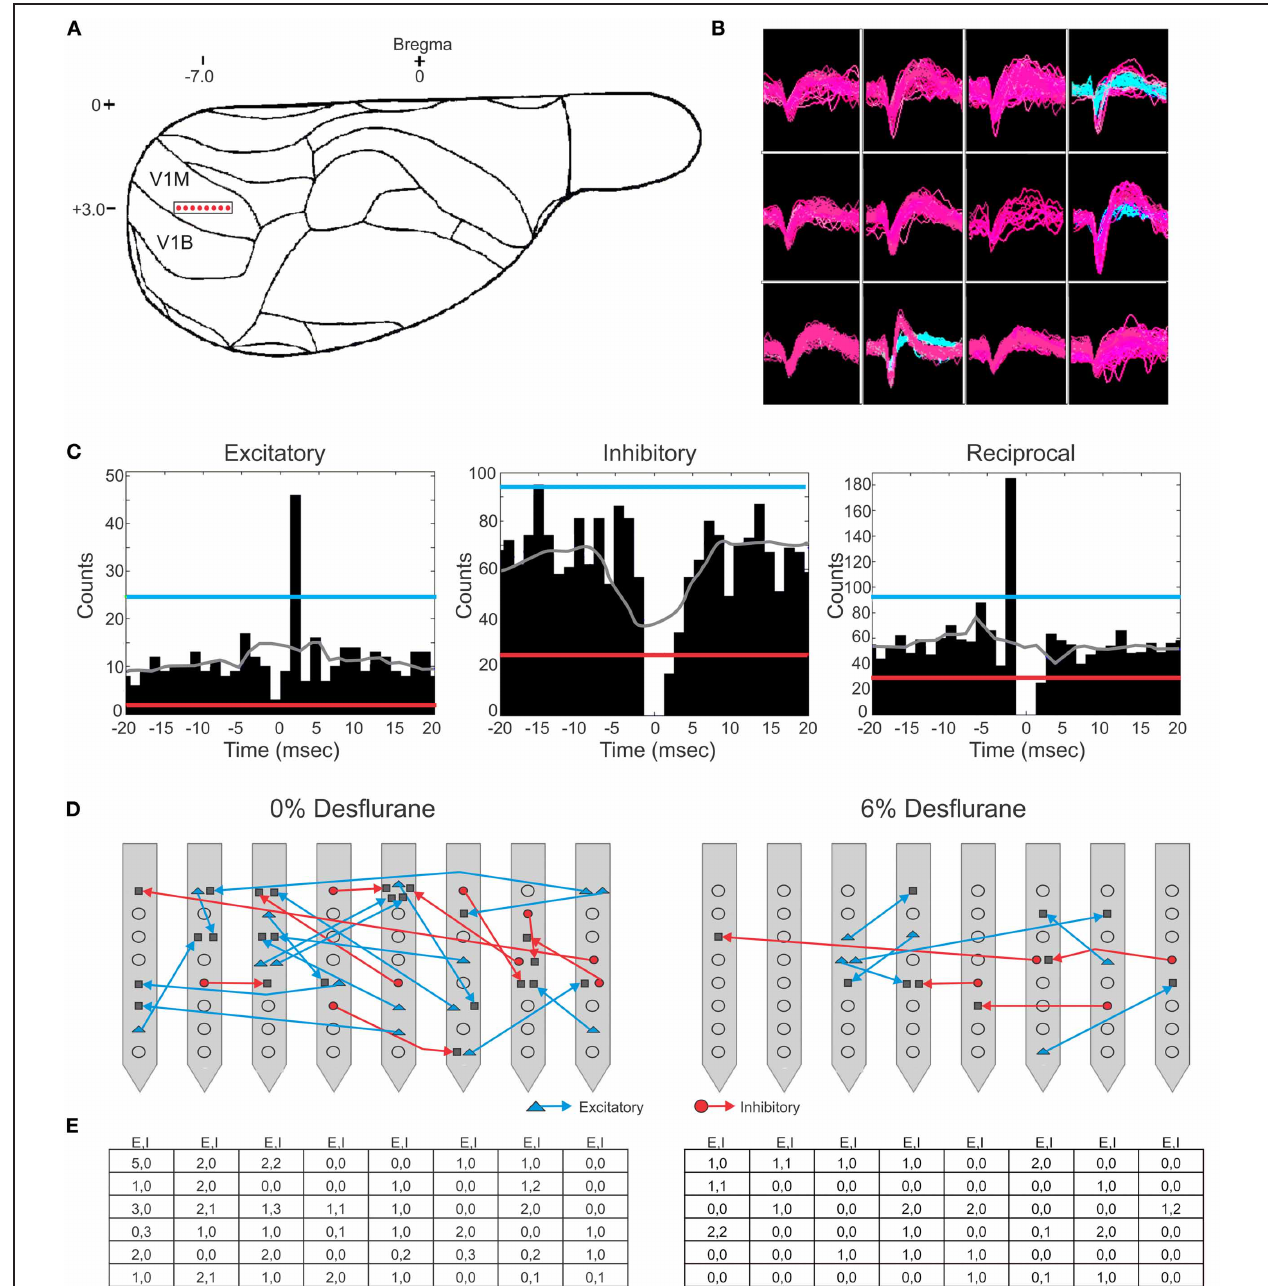
FIGURE 1 | Schematic of electrode placement and examples of recorded units and connection types. (A) Electrode placement of the 64-contact neural probe in the rat primary visual cortex monocular region (V1M) in the right hemisphere. Each dot represents the approximate location of an electrode shank. Schematic is overlaid on a stereotaxic drawing obtained from the Paxinos rat brain atlas. (B) Example of recorded spike waveforms from 12 channels in one experiment. Color waveforms represent online sorting of units during acquisition. (C) Spike cross-correlograms for excitatory, inhibitory and reciprocal connections. Thresholds are represented for excitatory connections (blue line), inhibitory connections (red line), and jittered mean displayed as gray trace. Bin size